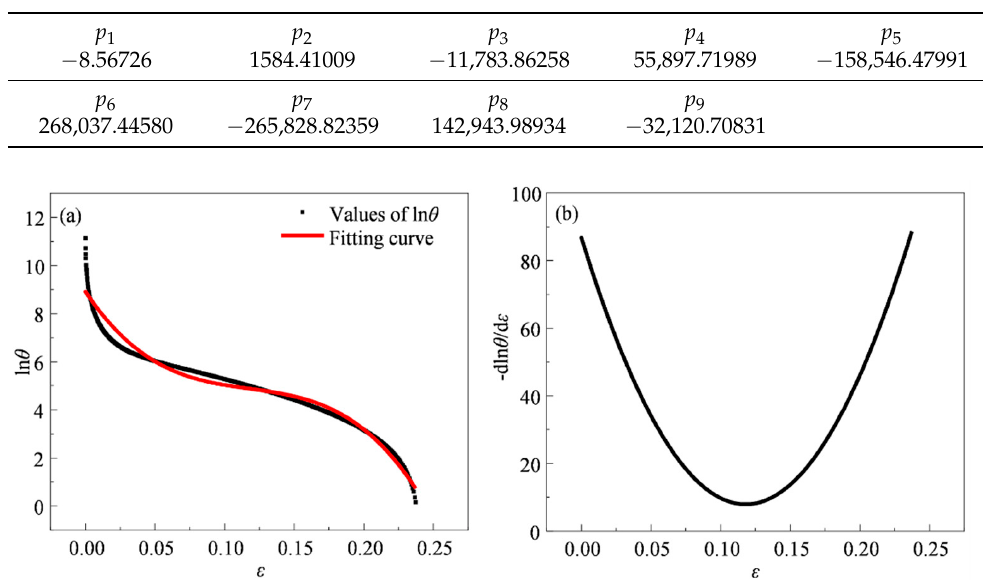
Figure 7. Relationship between ln𝜃– 𝜀 and − ∂(ln𝜃)/ ∂ − 𝜀 for S280 steel at a deformation tem- perature of 1150 °C and strain rate of 1 s − 1 : ( a ) ln𝜃 − 𝜀 ; ( b ) − ∂(ln𝜃)/ ∂𝜀 − 𝜀